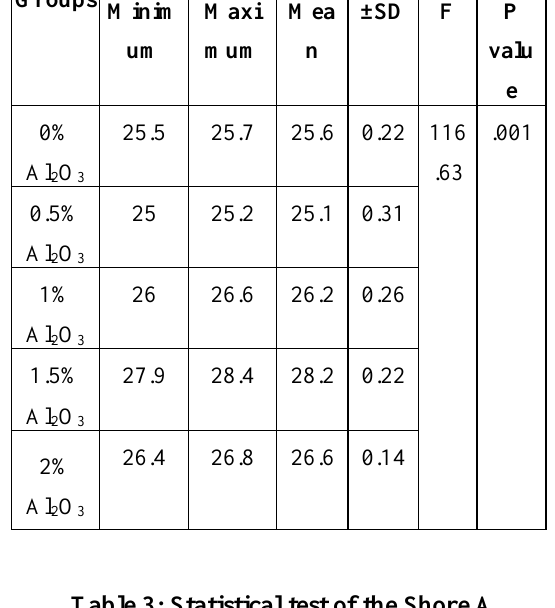
Table 3: Statistical test of the Shore